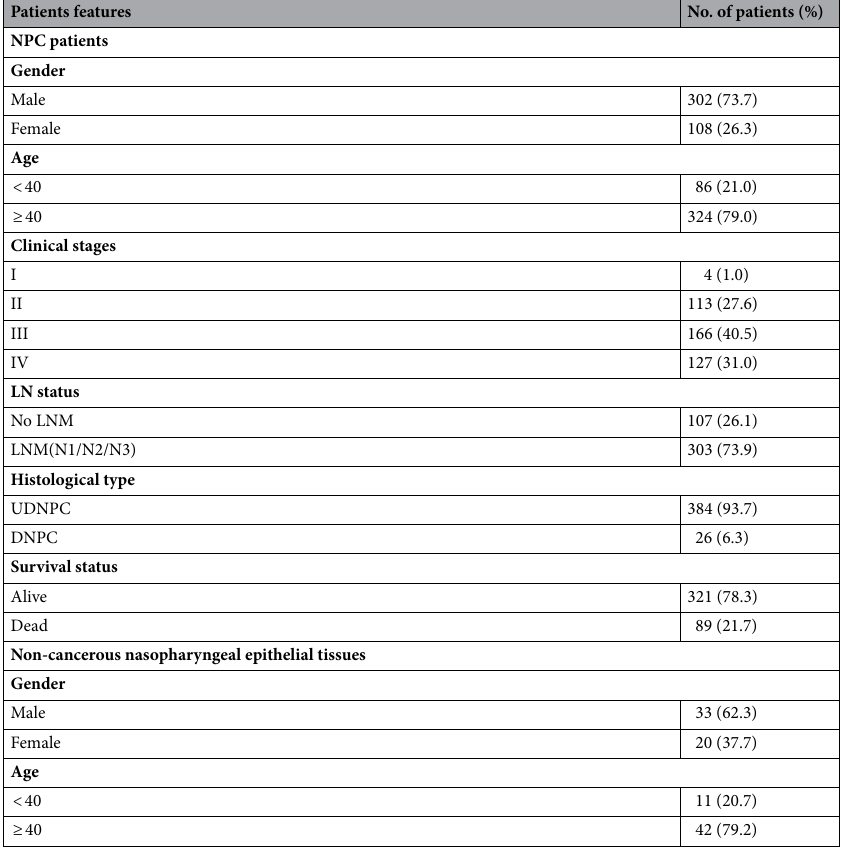
Table 1. Clinicopathological features of patients with NPC and non-cancerous nasopharyngeal epithelial tissues. DNPC differentiated non-keratinized nasopharyngeal carcinoma, UDNPC undifferentiated non- keratinized nasopharyngeal carcinoma, LN lymph node, LNM lymph node